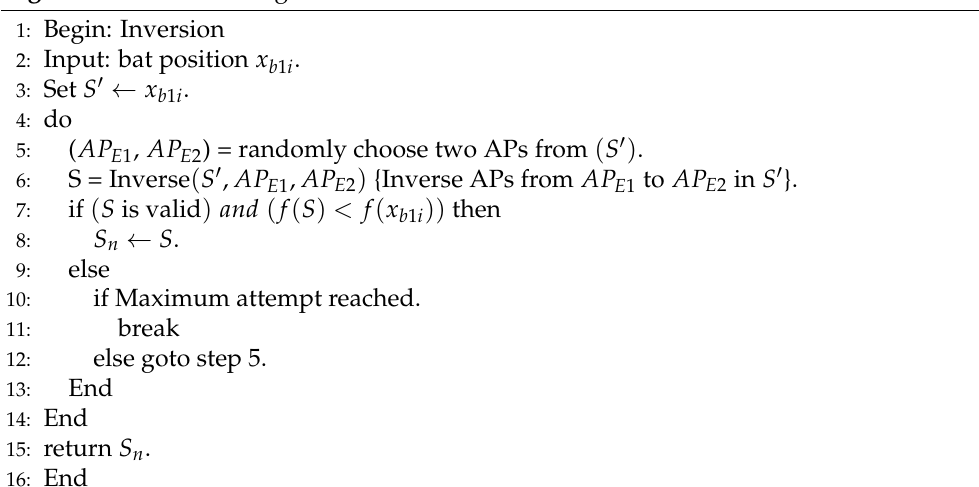
Algorithm 4 Inversion algorithm.